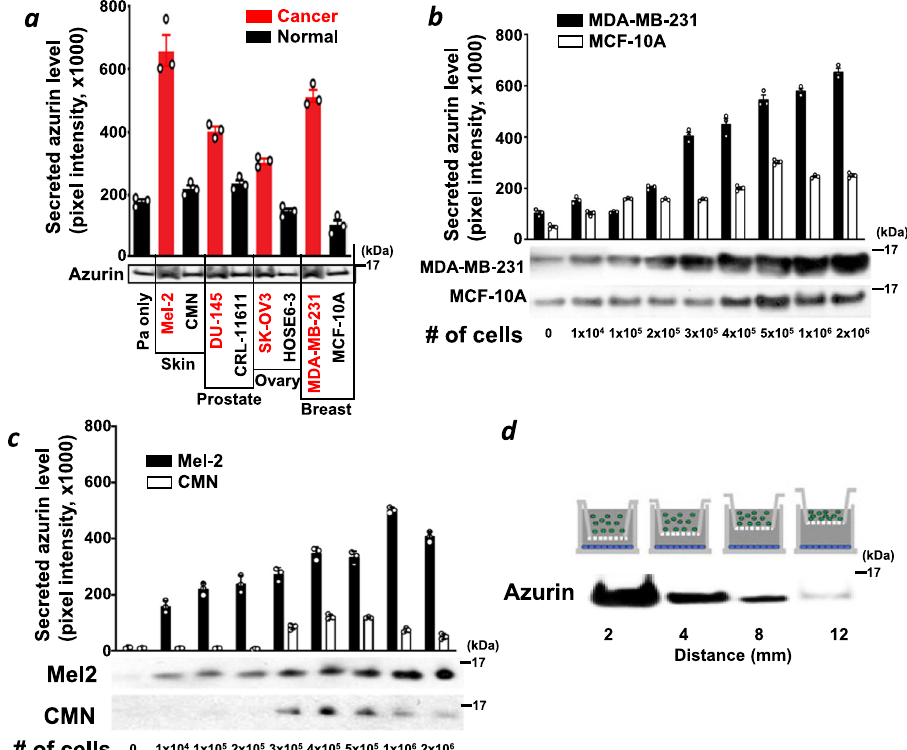
Fig. 1 Azurin secretion is stimulated by human cancer cells. a Induction of azurin secretion by P. aeruginosa in the presence of host cells. Human cells and P. aeruginosa were co-incubated for 30min at a concentration of 500,000 human cells/ml and P. aeruginosa (Pa) at an optical density (OD) = 0.3. Human cell lines derived from various tissues and tumors were used: melanoma Mel-2, congenital melanocytic nevus CMN, prostate cancer DU-145, normal prostate CRL- 11611, ovarian cancer SK-OV3, normal ovary HOSE6-3, breast cancer MDA-MB-231, and normal breast MCF-10A. Secretion of azurin by P. aeruginosa into the culture supernatant was assessed by western blot analysis; the graph shows the observed band intensities determined by a densitometer UN-SCAN-IT gel version 5.1. The mean + SE values were calculated for skin, prostate, ovarian, and breast cell pairs. b , c Azurin secretion is cancer cell dose-dependent. P. aeruginosa secretes higher levels of azurin in the presence of human breast cancer MDA-MB-231 ( b ) and melanoma Mel-2 cells ( c ) than in the presence of melanocytes (CMN) or non-malignant MCF-10A breast cells, in a dose-dependent manner. Cancer and normal/non-malignant cells were co-incubated with P. aeruginosa for 30min at concentrations ranging from 0 to 2,000,000 cells/ml and P. aeruginosa at OD = 0.3. Secretion of azurin by P. aeruginosa into the culture supernatant was assessed by western blot analysis; the graph shows the observed band intensities. The mean + SE values were calculated. d Soluble extracellular factors stimulate azurin secretion in a distance-dependent manner. Mel-2 and P. aeruginosa cells were separated by a permeable Transwell ® insert membrane with a pore size of 0.4 μ m. In this co-culture system, P. aeruginosa (OD = 0.3) and Mel-2 cells (3,000,000 cells/ml) were separated at distances ranging from 2mm to 12mm and incubated for 30min at 37°C (inset fi gure: schematic of the co-culture system. Green: P. aeruginosa , blue: Mel-2). Secretion of azurin by P. aeruginosa into the culture supernatant was assessed by western blot analysis; the graph shows the observed band